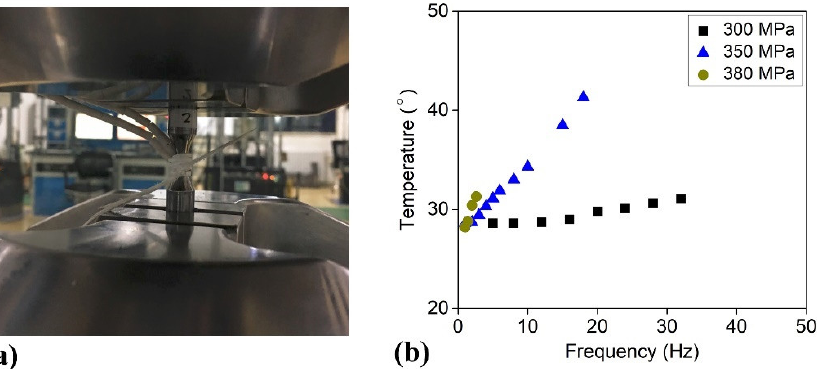
Figure 2. Measurement of surface temperature for experimental section of specimens. ( a ) Picture of the method for temperature measurement; ( b ) variation of temperature with loading frequency.